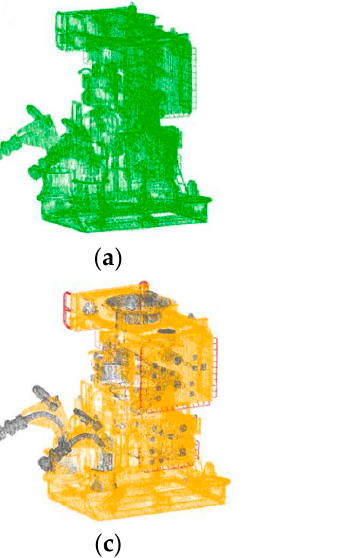
( d ) ID [29]. ( c ) Color;